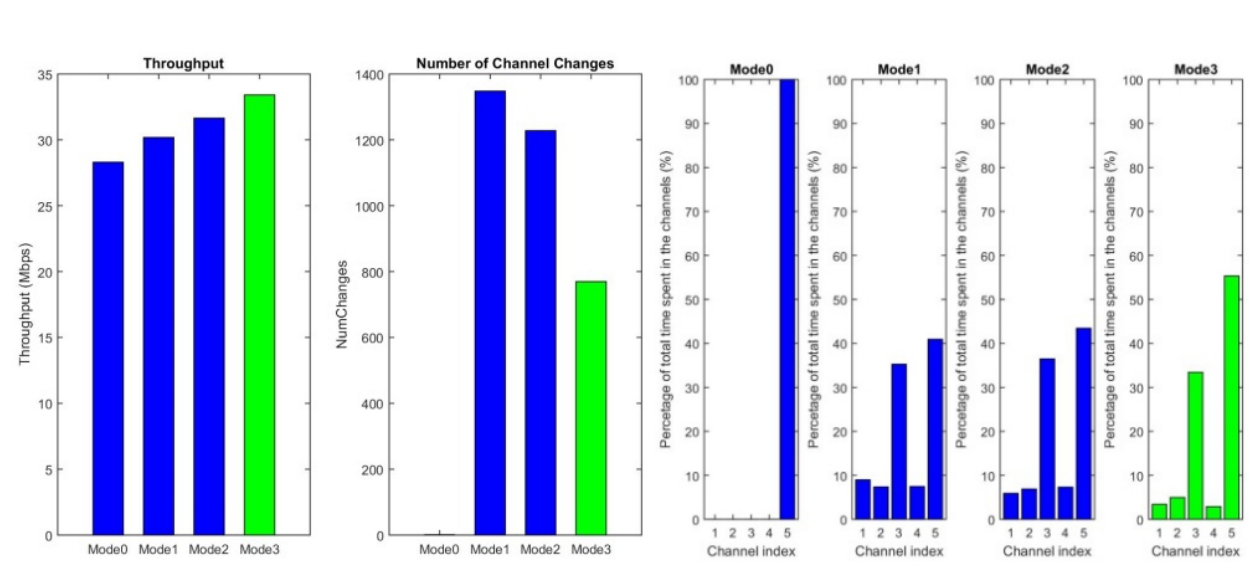
Figure 8 . Performance results with deterministic traffic.